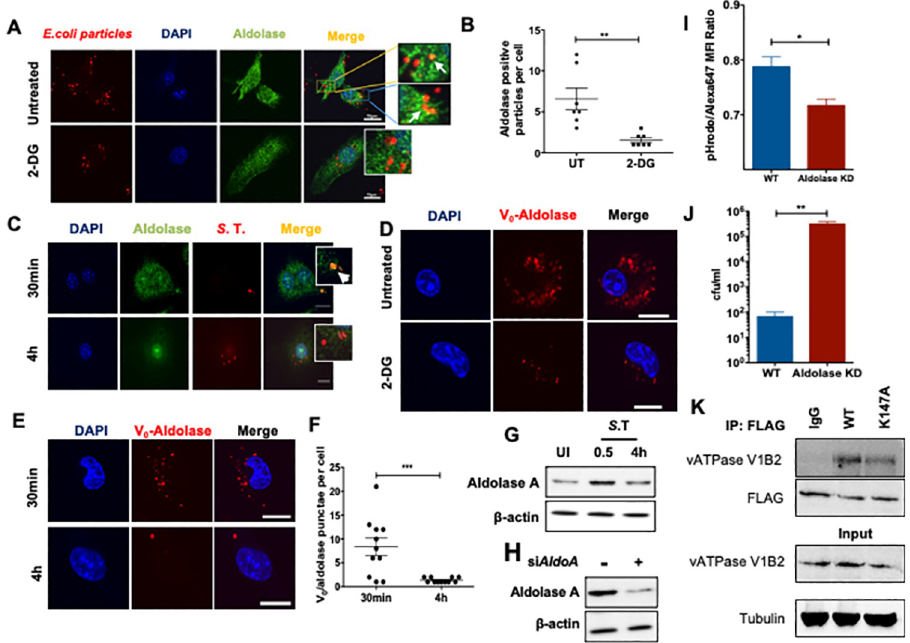
Fig 6. Aldolase A critically regulates the assembly of v-ATPase and phagosome acidification. (A) Confocal microscopy of 2-DG-treated BMDMs pulsed with E. coli inert fluorescent particles immune stained for aldolase A (green) (scale bars indicate 10 μ m). The image shown is representative of 3 individual experiments. (B) Quantification of aldolase A co-localization with E. coli in 2-DG-treated BMDMs (n = 7). (C) Confocal microscopy of S. Typhimurium-infected (S.T., red) BMDMs immune stained for aldolase A (green). The image shown is representative of 3 individual experiments. (D) PLA analysis of V0-aldolase A interaction in 2-DG treated BMDMs. The image shown is representative of 3 individual experiments. (E) PLA analysis of V0-aldolase A interaction in S. Typhimurium- infected BMDMs at indicated times. The image shown is representative of 3 individual experiments. (F) Quantification of V0 and aldolase A interaction in S. Typhimurium-infected BMDMs (n = 10). (G) Western blot analysis of Aldolase A expression in BMDMs infected with S. Typhimurium at indicated time points. ( H ) Knockdown of Aldolase A in BMDMs using control siRNA and Aldolase A-specific siRNA. The expression of Aldolase A was analyzed 48h post- transfection. (I) MFI of pHrodo-E. coli particles in transient aldolase A KD BMDMs normalized to Alexa647 MFI analyzed by flow cytometry (n = 3). (J) Quantification of S. Typhimurium CFU in aldolase A KD macrophages 24h post-infection compared to WT controls (n = 3). (K) BMDMs ectopically expressing FLAG-tagged WT or catalytic mutant aldolase A was immunoprecipitated and probed with indicated